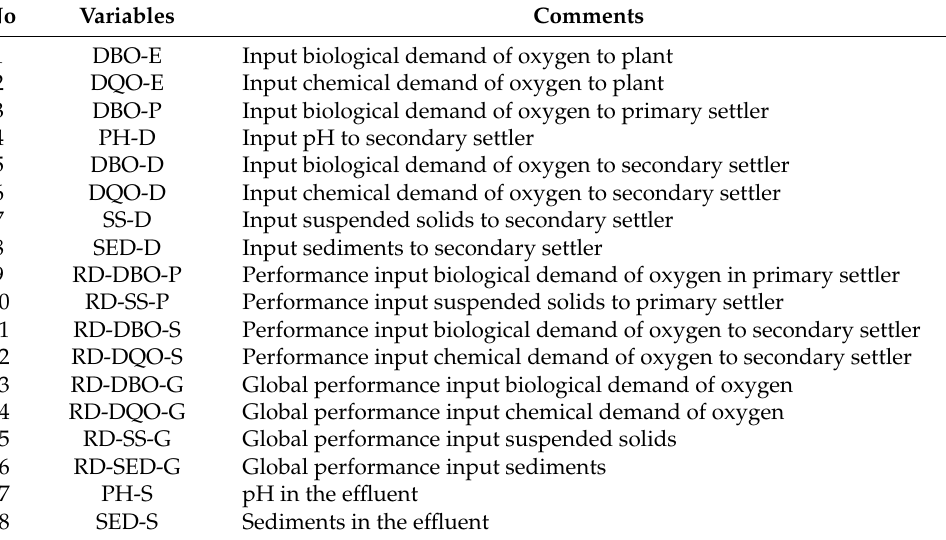
Table 1. Selected input variables for soft-sensor modeling.